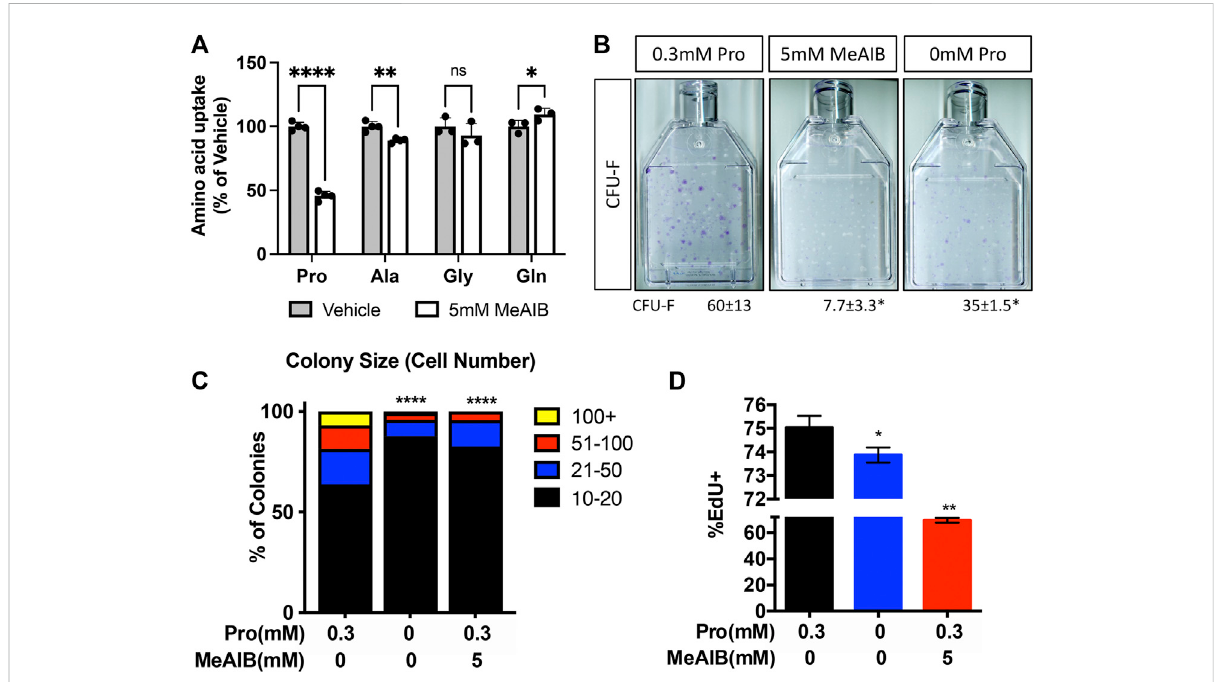
Proline and alanine uptake are required for SSPC proliferation. (A) Effect of MeAIB on radiolabeled amino acid uptake in high density BMSC isolatedfrom2-month-oldC57Bl6/Jmice.* p < 0.05,** p < 0.005.**** p < 0.00005.N ≥ 3 (B) RepresentativeimagesoftheeffectofMeAIBorproline withdrawal on CFU-F. Quanti fi cation of the number of colonies containing at least 20 cells is shown below each panel. N = 4 mice each treatment. (C) Prevalence of colonies binned for cell number. (D) Effect of MeAIB or proline withdrawal on EdU incorporation in bone marrow cells